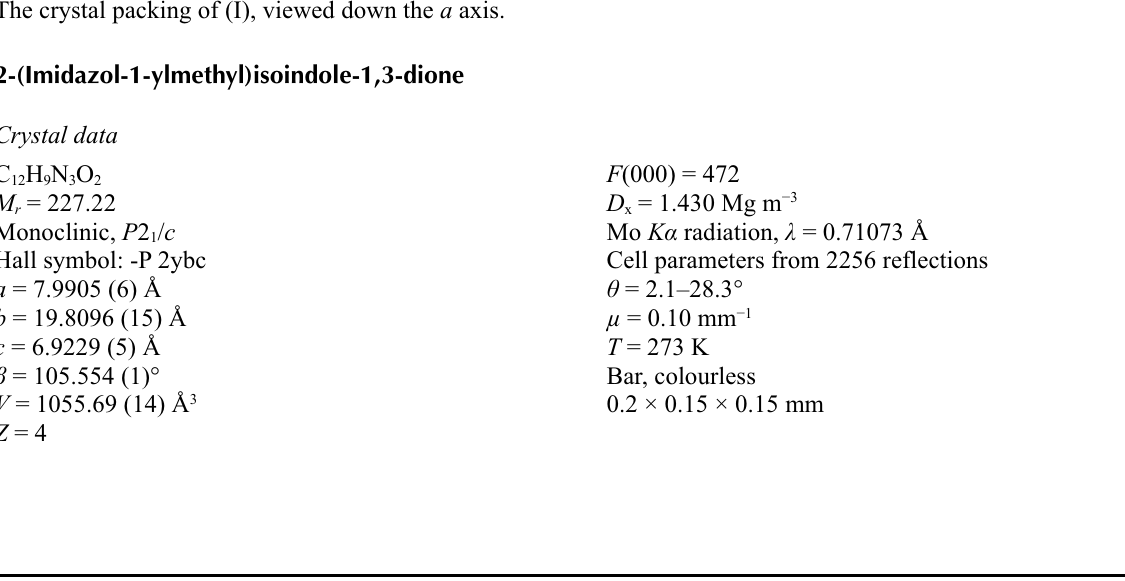
Figure 2 The crystal packing of (I), viewed down the a